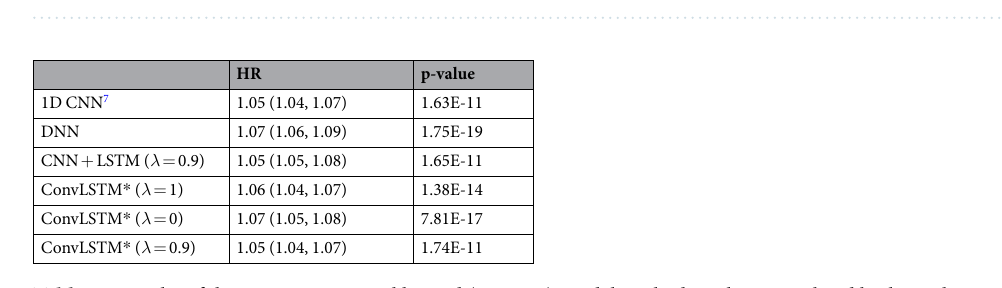
. Figure 6 shows the KM plots for